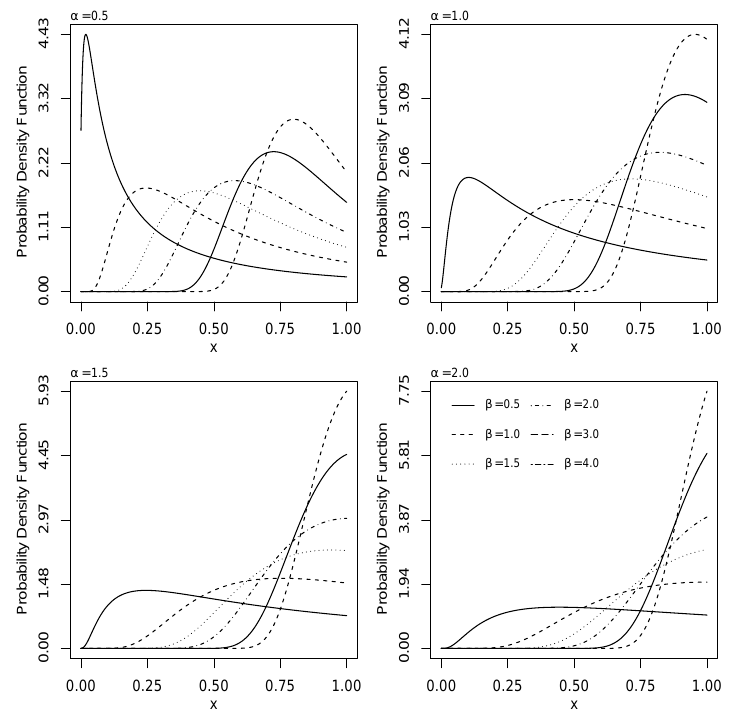
Figure 1 – Density plots of the unit-Gompertz distribution considering different values of α and β